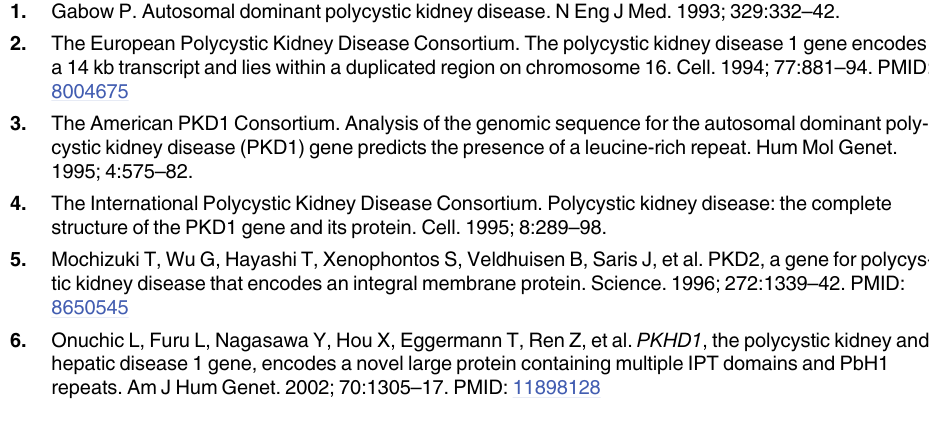
S1 Fig. Global genome-wide correlation of gene expression patterns to the one of Cys1 . Among ~40,000 transcripts profiled in 18 different renal anatomical structures at different developmental time-points that were deposited into the GUDMAP Database, the Cys1 expres- sion was highly correlated with the Mpkd2 gene candidate, Kif12